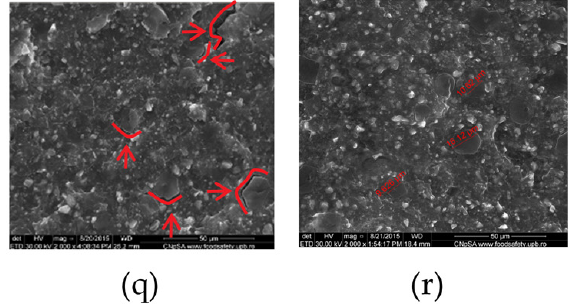
Figure 8. Targeted fillers: ( a ) starch; ( b ) PVOH; ( c ) CaCO 3 ; ( d ) wood flour and SEM morphologies (1000 × ) of the binary and ternary compounds achieved after improving the miscibility through two procedures (( e )—binary blend; ( f , g )—ternary blend/( f )—SEM surface/( g )—SEM fracture;